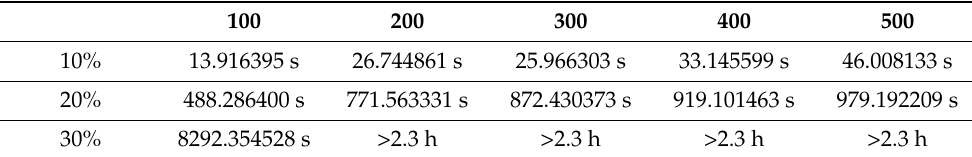
Table 1. FP-growth for the extracted